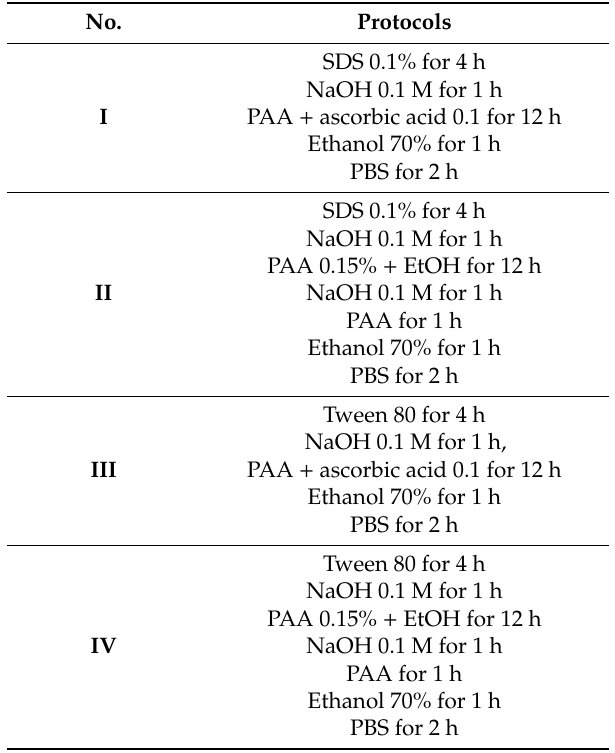
Table 1. Decellularization protocols for the bovine amniotic membranes (BAM).